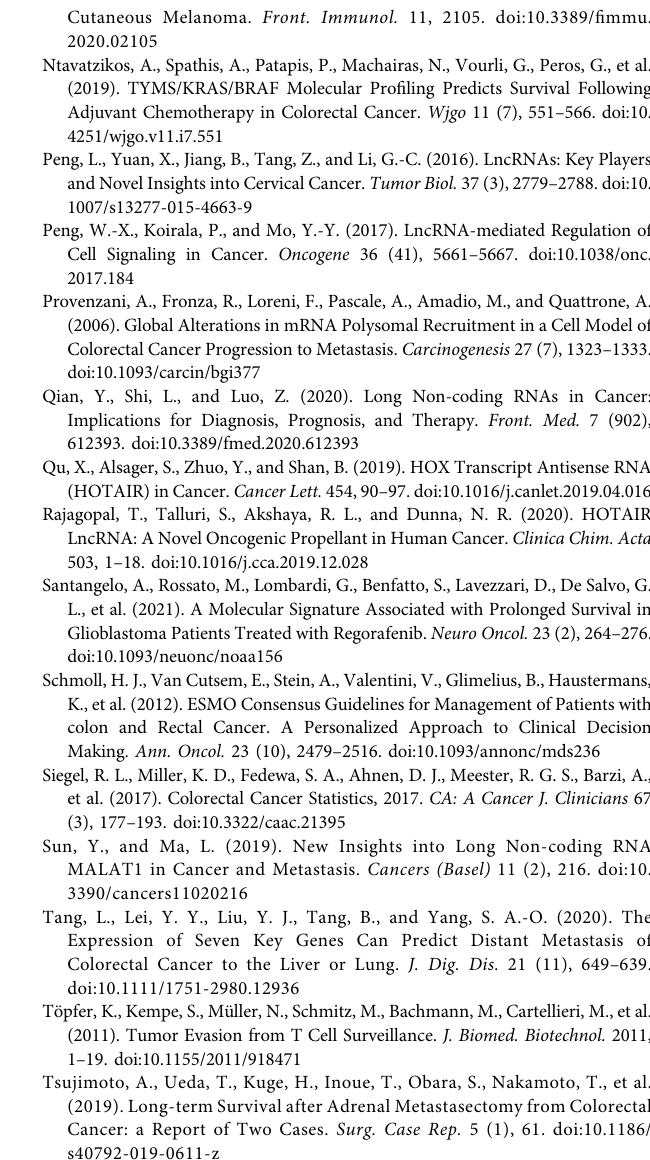
Supplementary Figure S2 | The expression of 8 lncRNAs in CRC and normal tissues from the GEO database suggested that CAPN10-AS1 (A) , SNHG7 (B) , NIFK-AS1 (C) , and ZEB1-AS1 (D) were highly expressed in CRC tissue compared with normal colon tissues, and Lnc00261 (E) was signi fi cantly downregulated